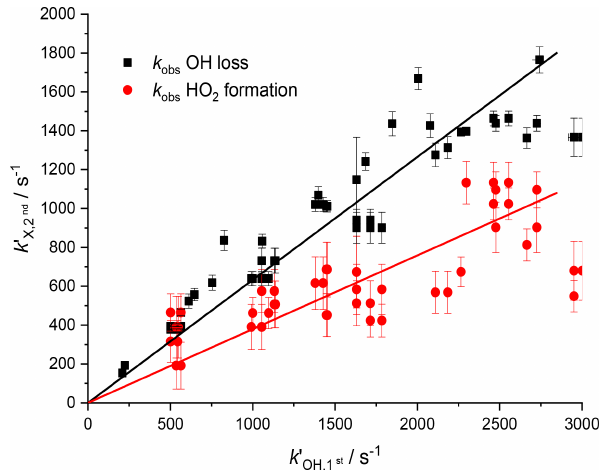
Figure 7. Relationship between the pseudo-1st-order rate coeffi- cient for OH loss observed in the first cell ( k (cid:48) OH , 1st ) from the reac- tion of OH with H 2 O 2 and the observed rate coefficients measured in the second cell ( k (cid:48) X , 2nd where X = OH loss (black squares) or HO 2 production (red circles)). A non-linear fit can be used to as- sign removal rates and HO 2 formation rates to traces observed in the second cell below 2500s − 1